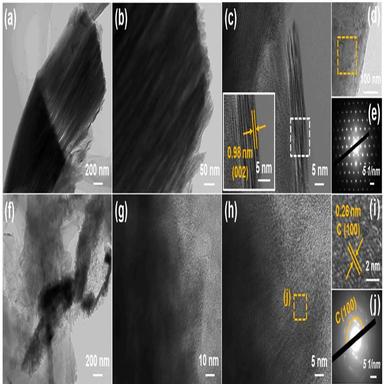
TEM image (a), high–resolution TEM images (b–c) and (d), SAED pattern (e) of Fig. 3(d). TEM image (f), high–resolution TEM images (g–h) and (i) of CMAC, SAED pattern (j) corresponding to Fig. 3(h).